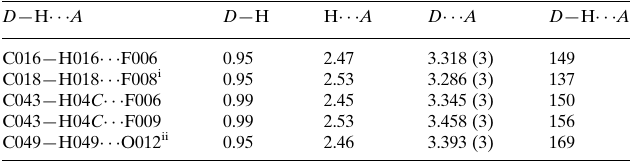
Hydrogen-bond geometry (A˚ , (cid:4)